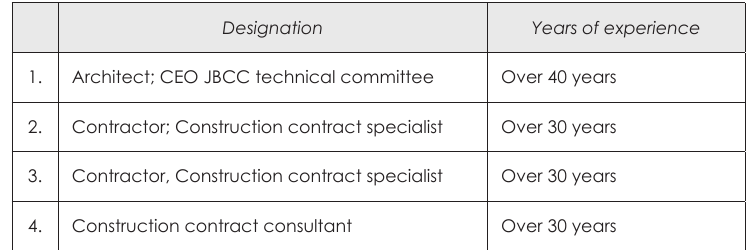
Table 2: Focus-group